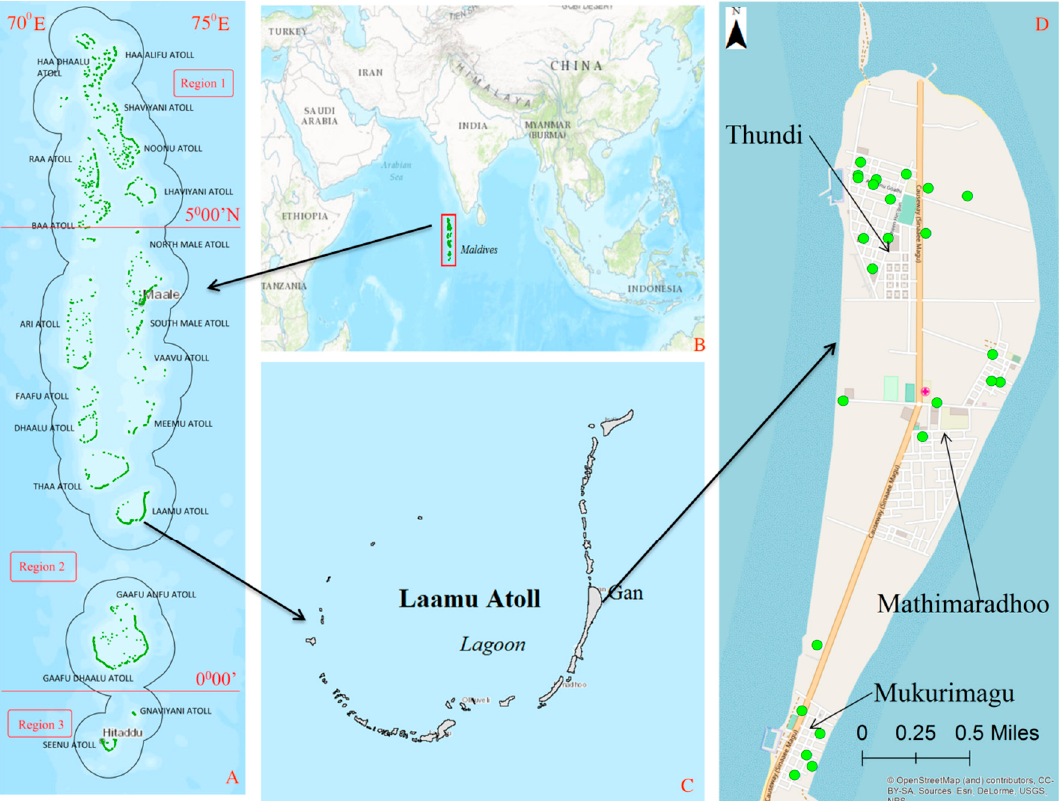
Figure 1. Map of the Republic of Maldives ( A ), located in Indian Ocean ( B ), with the Laamu atoll ( C ) and Gan Island ( D ) shown on the inset figures. Gan Island has a surface area of about 598 ha and a population of 4280 located within three main villages: Thundi, Mathimardhoo, and Mukurimagu. The green dots in the Gan Island inset figure show the location of the monitoring wells used to measure groundwater level and groundwater salinity concentration.